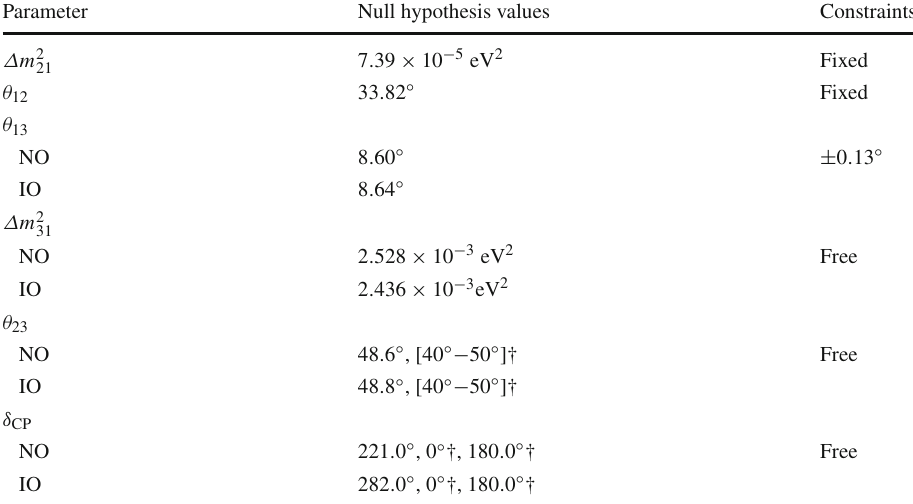
Table 2 Oscillation parameters values used for different analyses for the null hypothesis and constraints applied during the LL ef f minimisation. The values are taken from [6] except the ones identified by a dagger (†) which are extra θ 23 and δ CP test points used for the NMO sensitivity